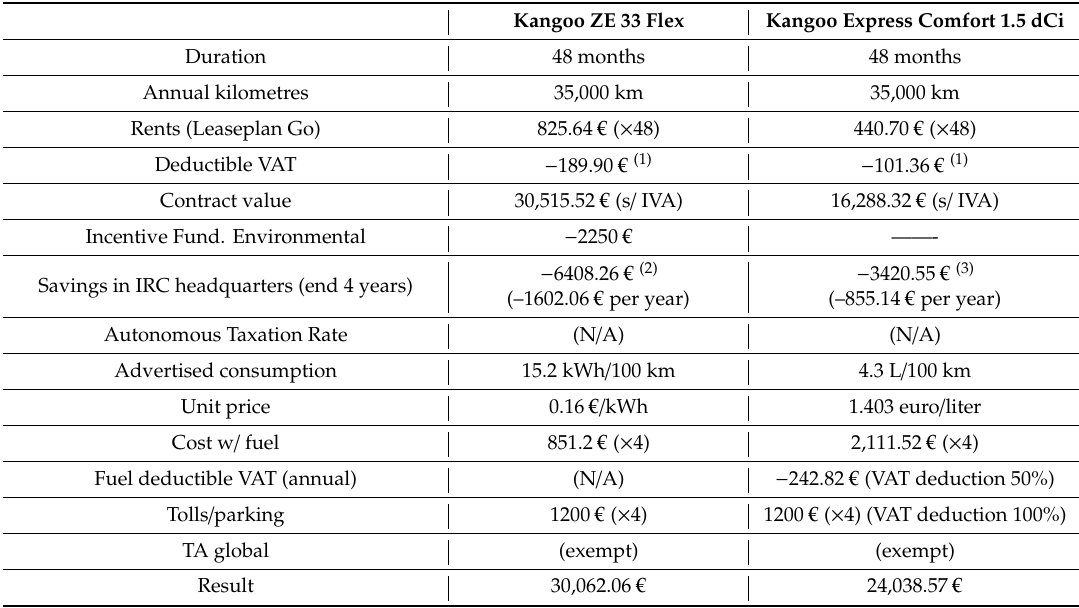
Table A4. 4-year exercise demonstration - Renting (Comparison of light commercial